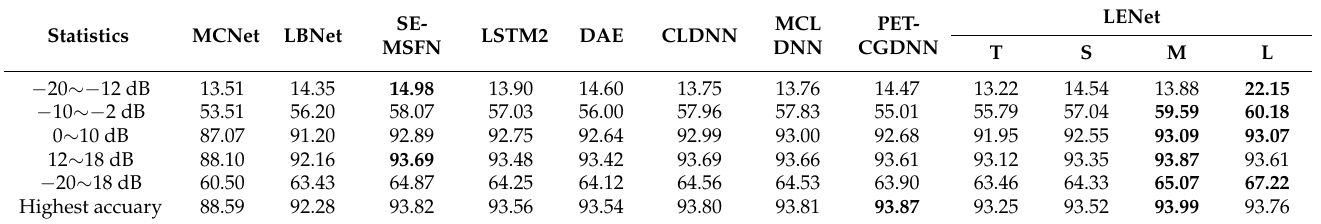
Table 4. Results of statistical analysis of all models’ classification accuracy on the 2016B dataset. The top2 for each statistic are highlighted.